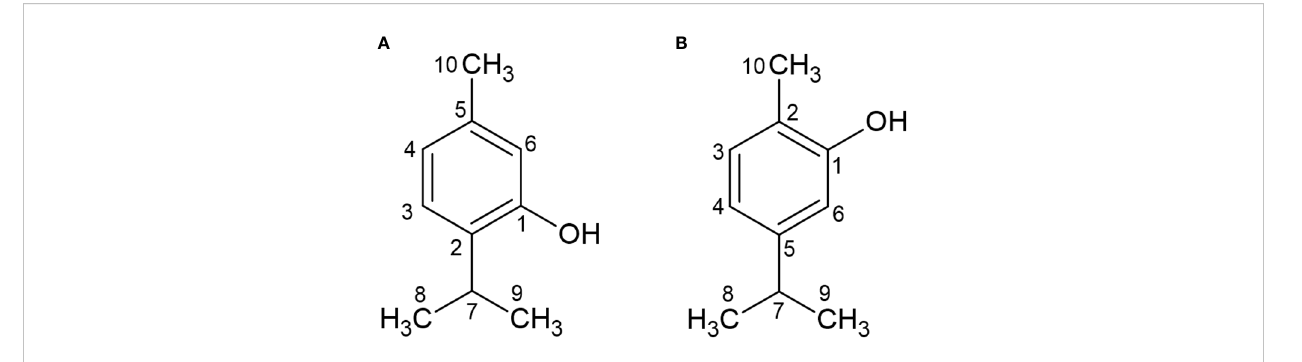
FIGURE 1 Chemical structure of Thymol (A) and Carvacrol (B)